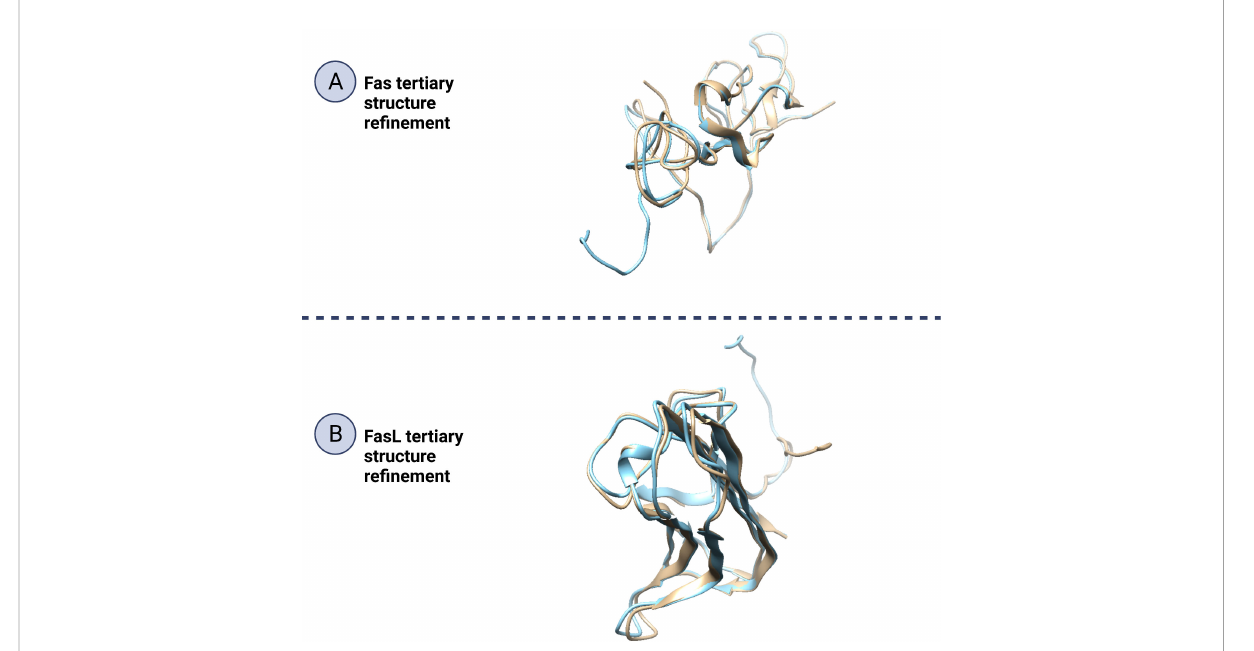
FIGURE 9 Re fi nement of Fas and FasL tertiary structure. Protein structure re fi nement is the determination and improving of a protein ’ s structural properties. In this fi gure ( A ; Fas and B ; FasL), by beige/blue colors, the initial and re fi ned structure have been matched to show how the 3D structures, such as beta-sheets, alpha-helices and coils have been altered to improve the protein quality. Also, a signi fi cant portion of the re fi ned structure is made of beta-sheets or alpha-helices indicating good structural